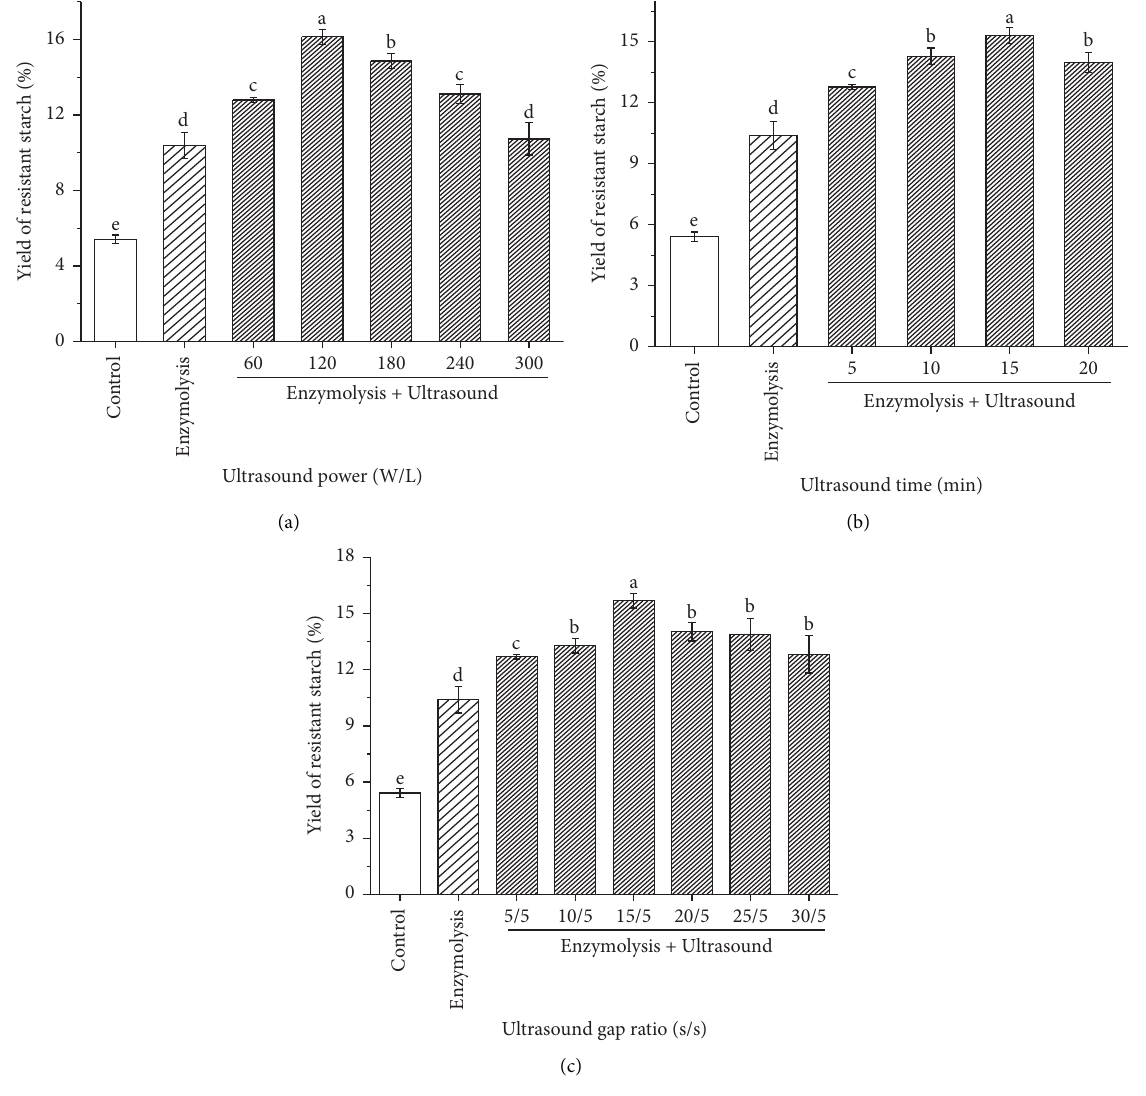
Figure 1: Efects of ultrasound treatment using diferent powers (a), times (b), pulsed on-time/of-time parameter (c) on resistant starch yield. Diferent letters indicate signifcant diferences ( p < 0 .